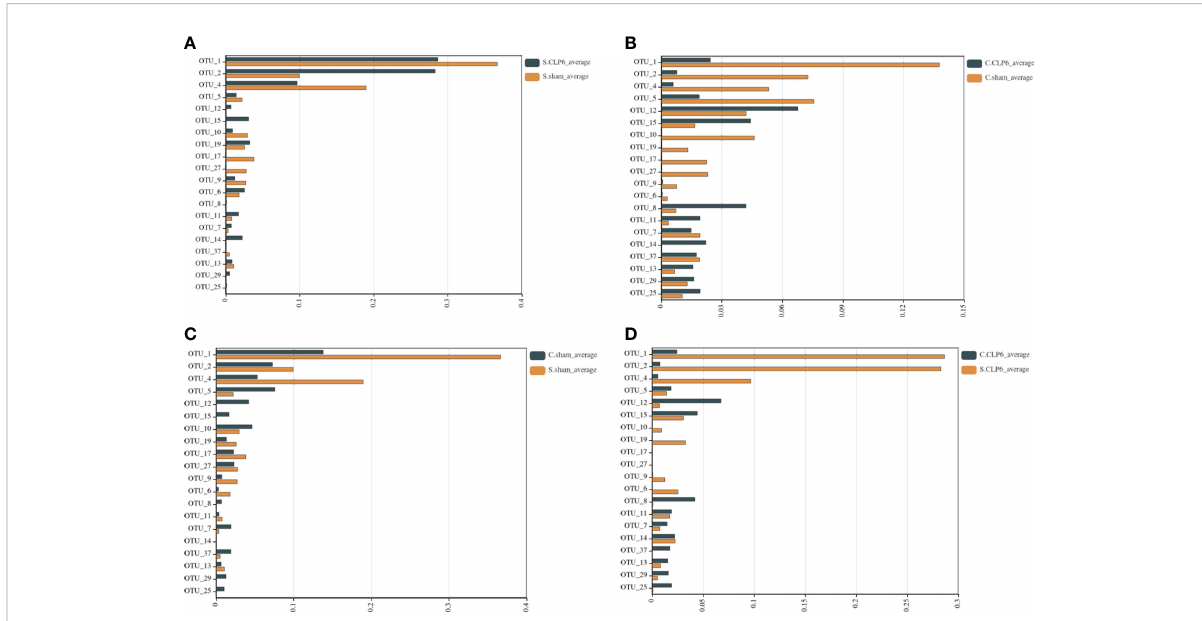
FIGURE 6 Comparison of gut microbiota in different intestinal segments of the two groups. The abscissa represents the abundance values, and the ordinate represents the bacterial groups. The Wilcoxon signed-rank sum test was used. OTU_1, OTU_2, OTU_4, and OTU_9 — k: Bacteria, p: Firmicutes, c: Bacilli, o: Lactobacillales, f: Lactobacillaceae, g: Lactobacillus . OTU_5, OTU_12, OTU_15, OTU_11, OTU_14, OTU_13, OTU_29, and OTU_25 — k: Bacteria, p: Bacteroidetes, c: Bacteroidia, o: Bacteroidales, f: Muribaculaceae . OTU_10 — k: Bacteria, p: Firmicutes, c: Erysipelotrichia, o: Erysipelotrichales, f: Erysipelotrichaceae, g: Dubosiella , s: Firmicutes_bacterium_M10_2 . OTU_19, OTU_17, and OTU_27 — k: Bacteria, p: Firmicutes, c: Erysipelotrichia, o: Erysipelotrichales, f: Erysipelotrichaceae, g: Allobaculum, s: uncultured_bacterium. OTU_6 — k: Bacteria, p: Firmicutes, c: Clostridia, o: Clostridiales, f: Clostridiaceae_1, g: Candidatus_Arthromitus . OTU_8 — k: Bacteria, p: Bacteroidetes, c: Bacteroidia, o: Bacteroidales, f: Prevotellaceae, g: Alloprevotella, s: uncultured_Bacteroidales_bacterium. OTU_7 — k: Bacteria, p: Verrucomicrobia, c: Verrucomicrobiae, o: Verrucomicrobiales, f: Akkermansiaceae, g: Akkermansia . OTU_37: k: Bacteria, p: Firmicutes, c: Clostridia, o: Clostridiales, f: Lachnospiraceae, g: Lachnospiraceae_NK4A136_group . (A) Comparison of gut microbiota in the small intestine of the sham group and the CLP6h group. (B) Comparison of gut microbiota in the colon of the sham group and the CLP6h group. (C) Comparison of gut microbiota between the small intestine in the sham group and the colon in the sham group. (D) Comparison of gut microbiota between the small intestine of the CLP6h group and the colon of the CLP6h